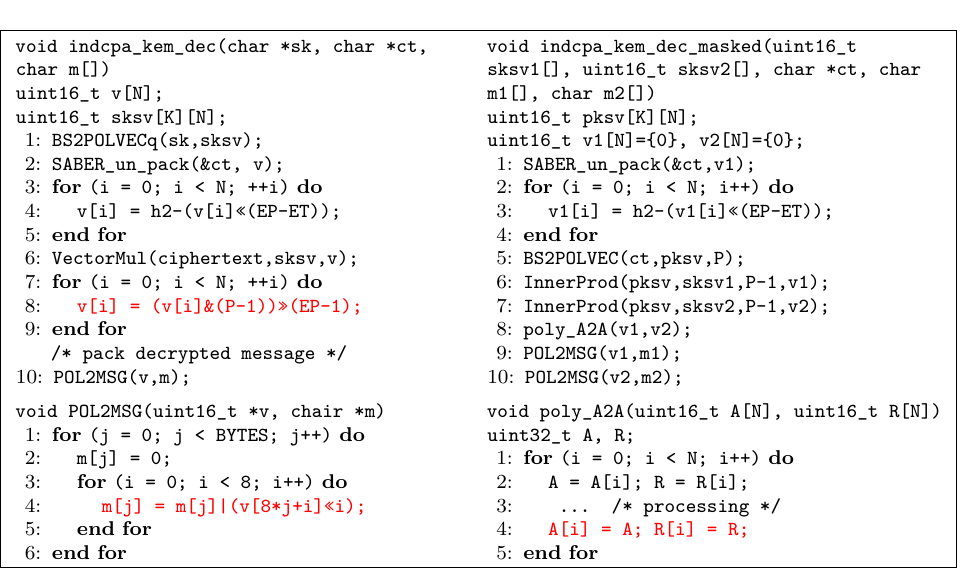
Figure 4: C code of non-masked and masked implementations of Saber.PKE.Dec() from [BDK +